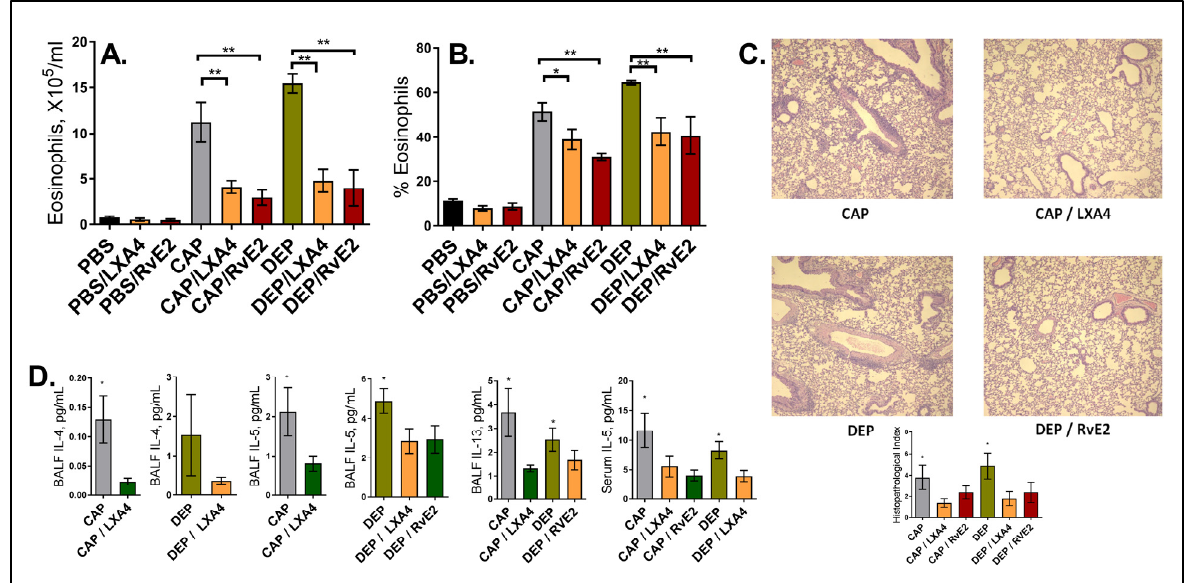
Figure 2. LxA4’s and RvE2’s e ff ect on resolution of AI after the low-dose allergen . ( A ) BAL eo- sinophil counts, ( B ) percentage of eosinophils of total BAL cells, ( C ) lung histopathology repre- sentative images (H and E staining, ×100) and scoring, and ( D ) select cytokine measurements in BAL fl uid and serum. Only 1 representative experiment of 3 is shown; (n) = 40. * p < 0.05, and ** p < 0.01.